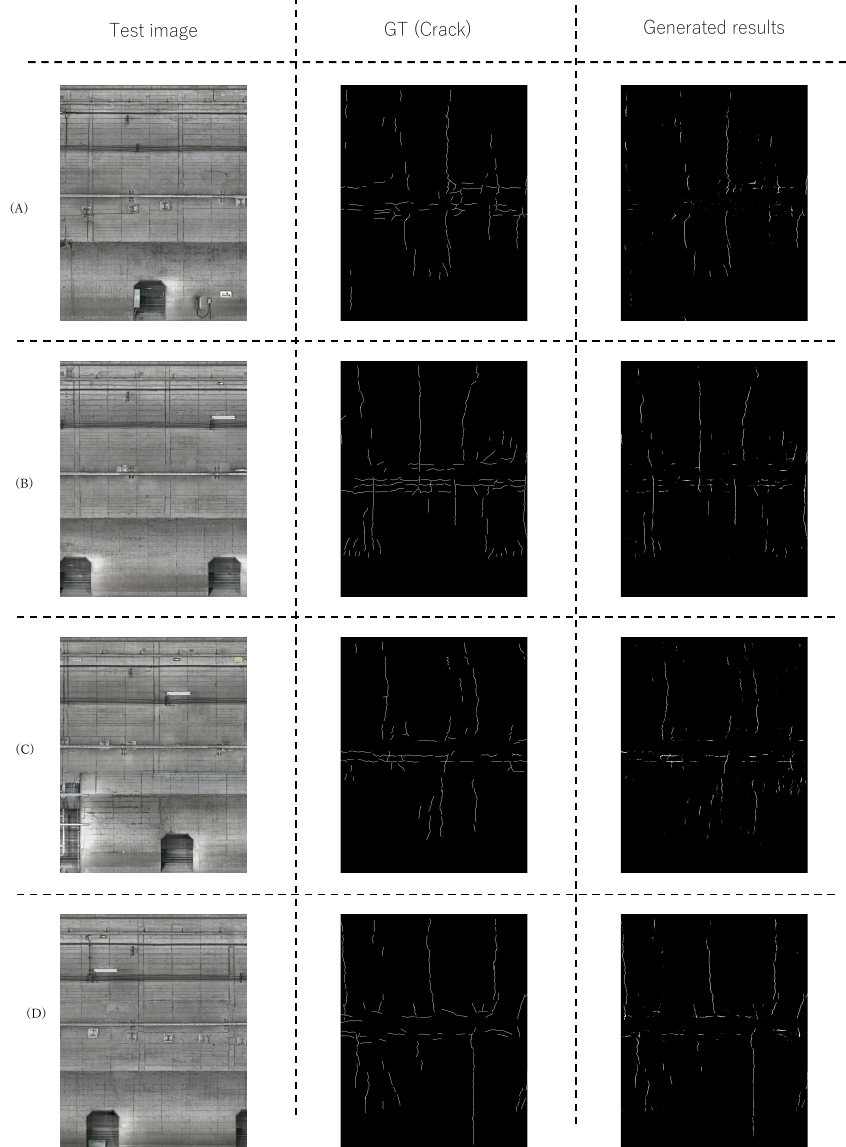
Figure 5. Examples of the resultsof the proposed method in line A. Figures ( A – D ) show the tunnel walls at various locations on line